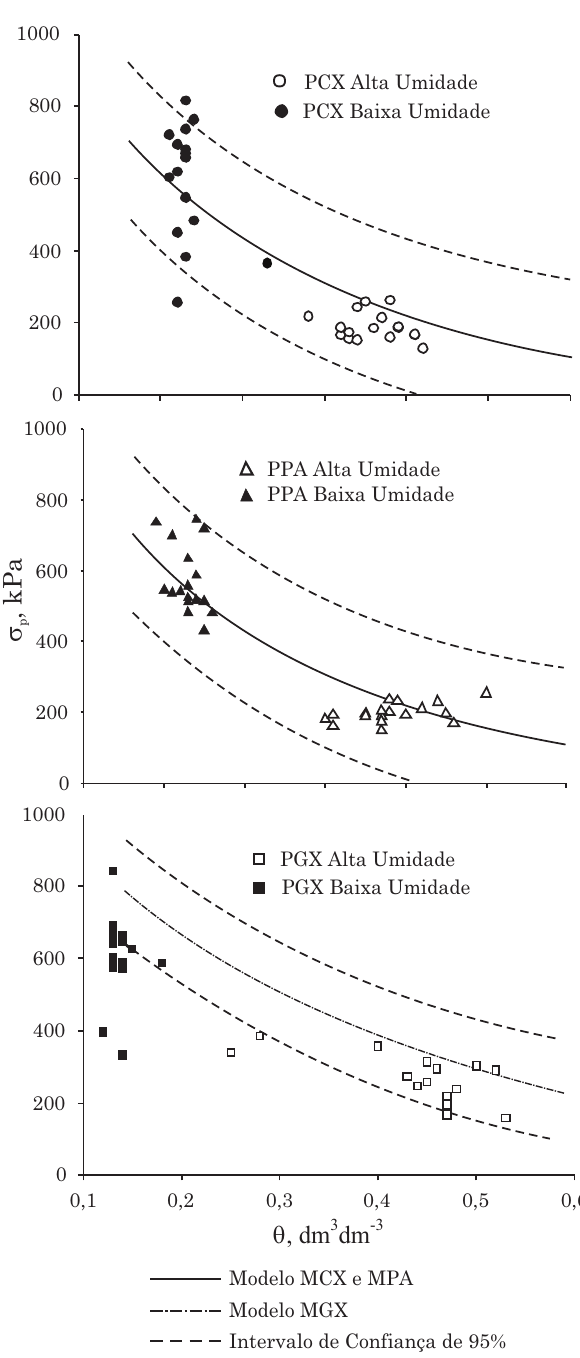
Intervalo de Confiança Figura 4. Modelos de capacidade de suporte de carga descrevendo o impacto da pastagem em amostras de solo equilibradas em alta e baixa umidade, para MCX, MPA e MGX.